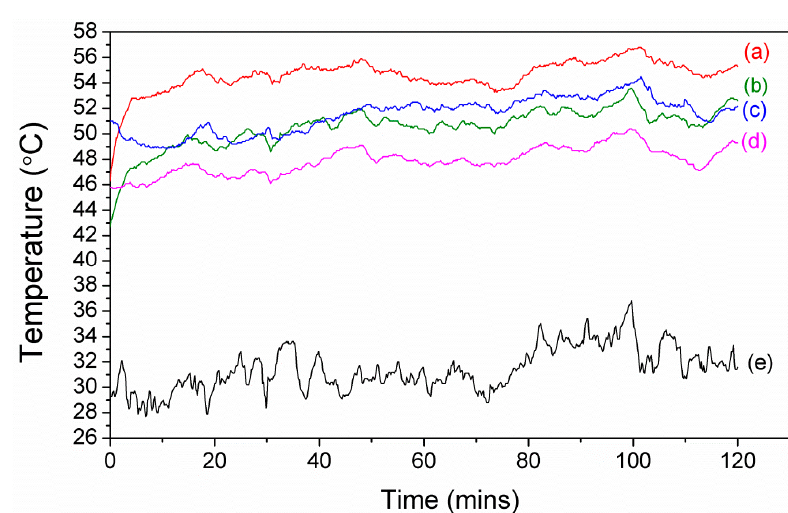
Figure 12. ( a ) Air temperature trend of polyethylene (PE) film inside the greenhouse; ( b ) Temperature trend of PE film on the cladding surface; ( c ) Air temperature trend of 1%S double inside the greenhouse; ( d ) Temperature trend of 1%S double on the cladding surface; ( e ) Ambient air